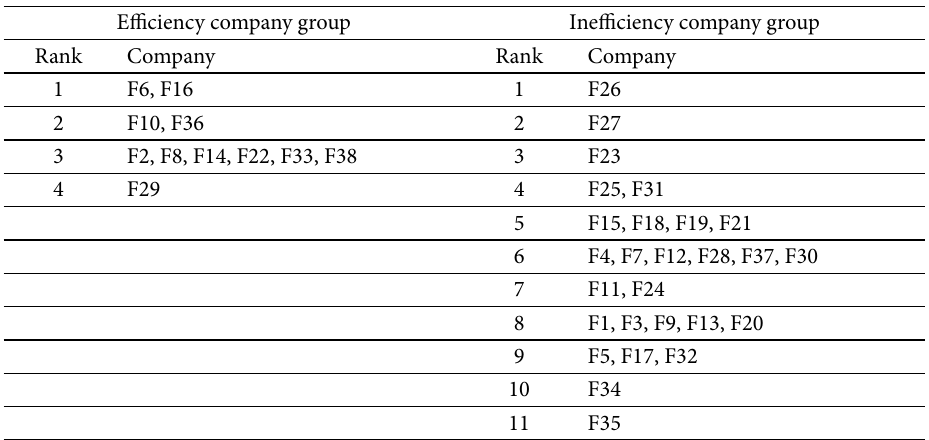
Table 10. The ranking results of efficiency and inefficiency company groups Efficiency company